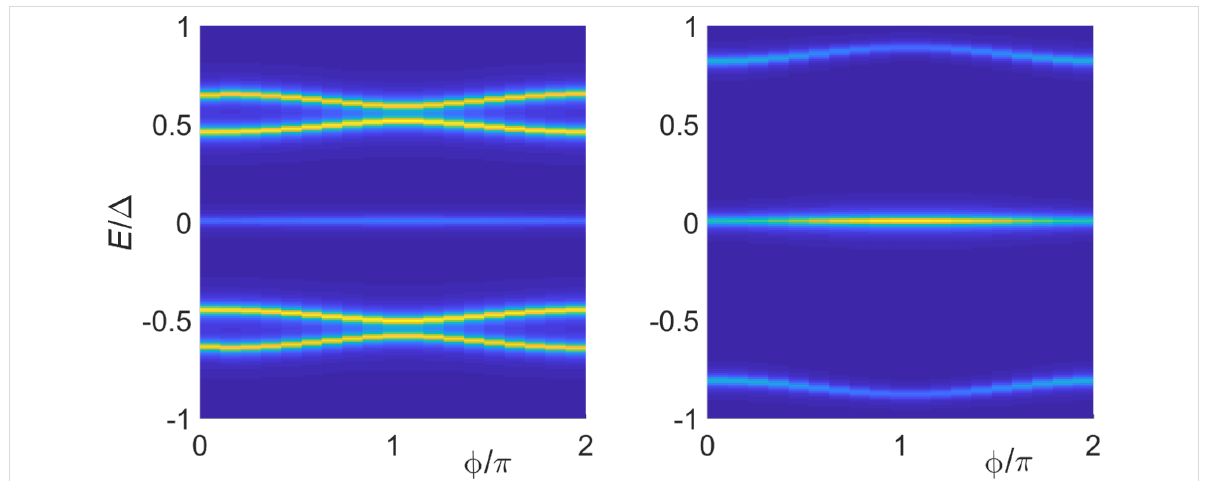
Figure 3: Phase-dependent ABS spectrum from mean-field theory for S–QD–TS junctions as in Figure 2 but with U > 0 and ε 0 = − U /2. We put Δ p = Δ , B y = 0, and Γ S = Γ TS = Γ . The color code is as in Figure 2. The left panel is for U = Δ , Γ = 0.5 Δ , and B x = B z = B / with B = 0.5 Δ [cf. the right panel of Figure 2]. The right panel is for U = 10 Δ , Γ = 4.5 Δ , B x = 15 Δ , and B z = 0.